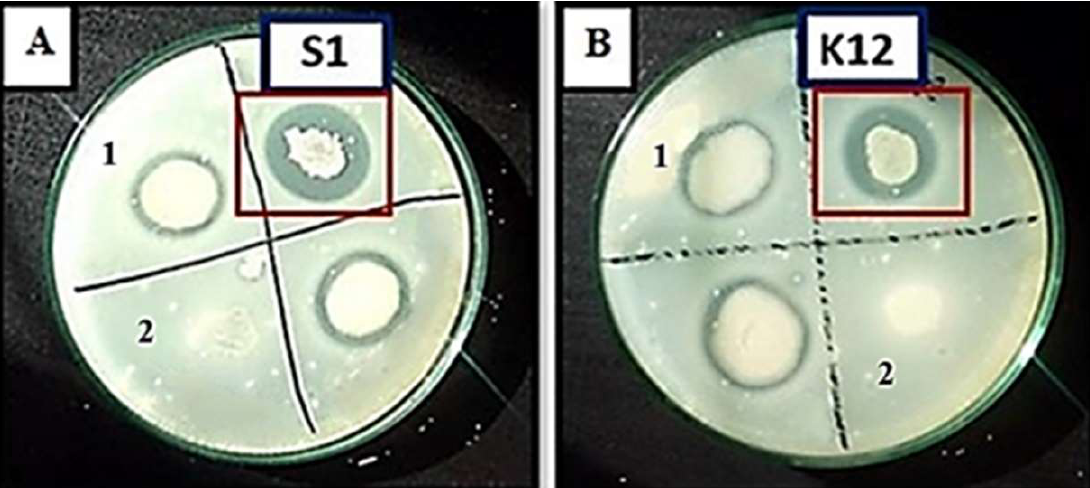
Figure 2. Zones of hydrolysis formed on skim milk agar plates by ( A ) B. subtilis S1, and ( B ) B. amyloliquefaciens KSM12. Representative halo zone produced by the rest protease producers (1). Bacterial strains with no protease production (2).